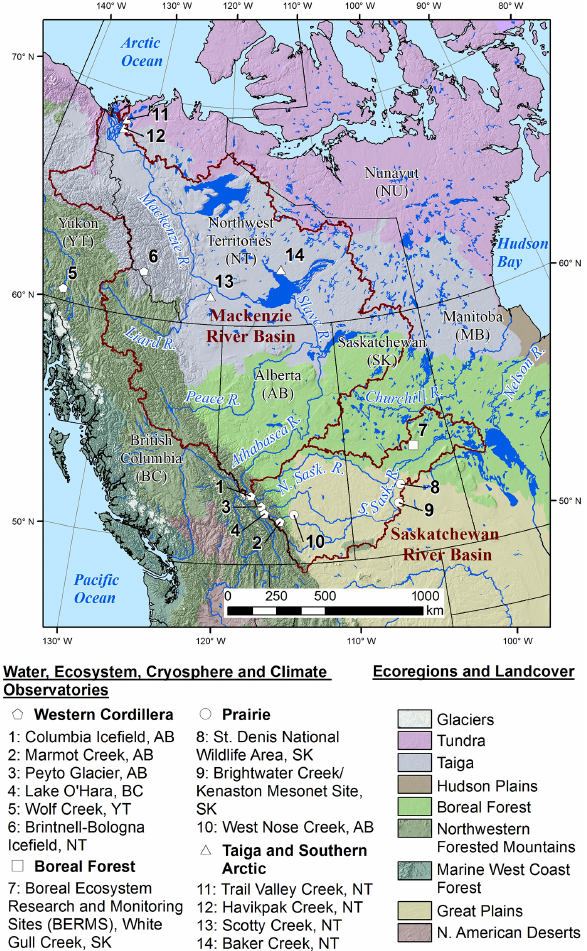
Figure 1. Map of the CCRN geographic study domain in the interior of western and northern Canada, showing the major river systems, ecoregions, and land cover, as well as the location of the WECC observatories. Source data are from the North American Environ- mental Atlas (http://www.cec.org/sites/default/atlas/map/) and the National Hydro Network (http://www.geobase.ca); the projection is UTM Zone 11 on the North American Datum of